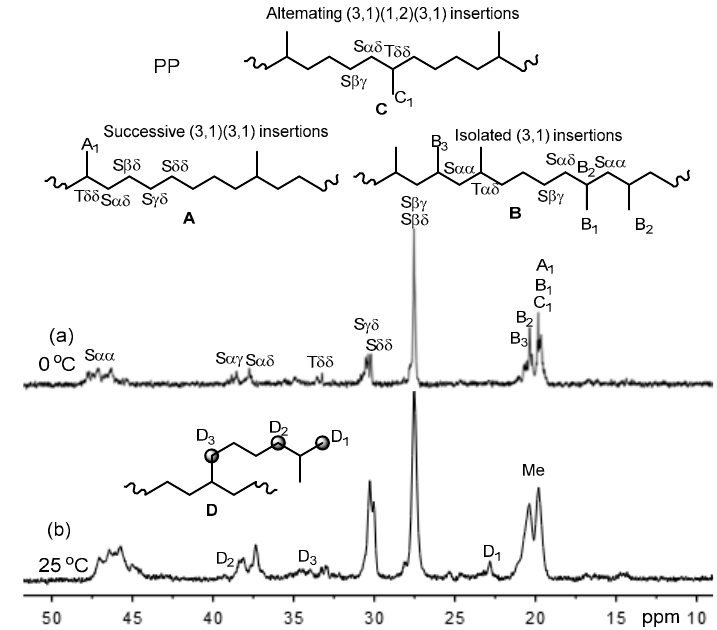
Figure 3. 13 C NMR spectra of polypropylenes obtained by 2 -MMAO at ( a ) 0 and ( b ) 25 °C (Table 1, entries 1 and 2).